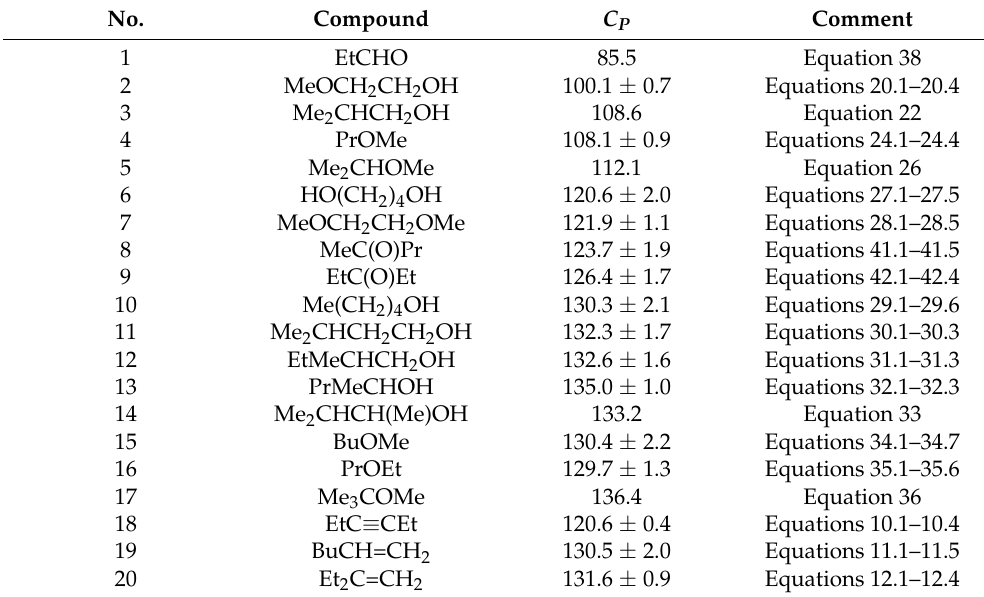
Table 3. Gas-phase isobaric molar heat capacities C P , J/mol · K, 298 K estimated by the homodesmotic method 1 .